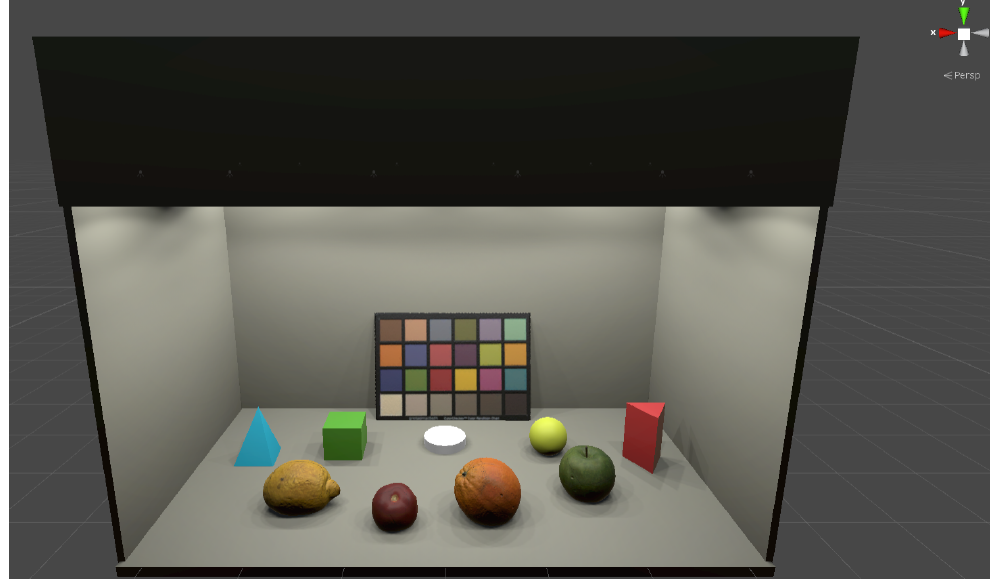
Figure 1. Proposed virtual reality scenario for the introduction of hyperspectral